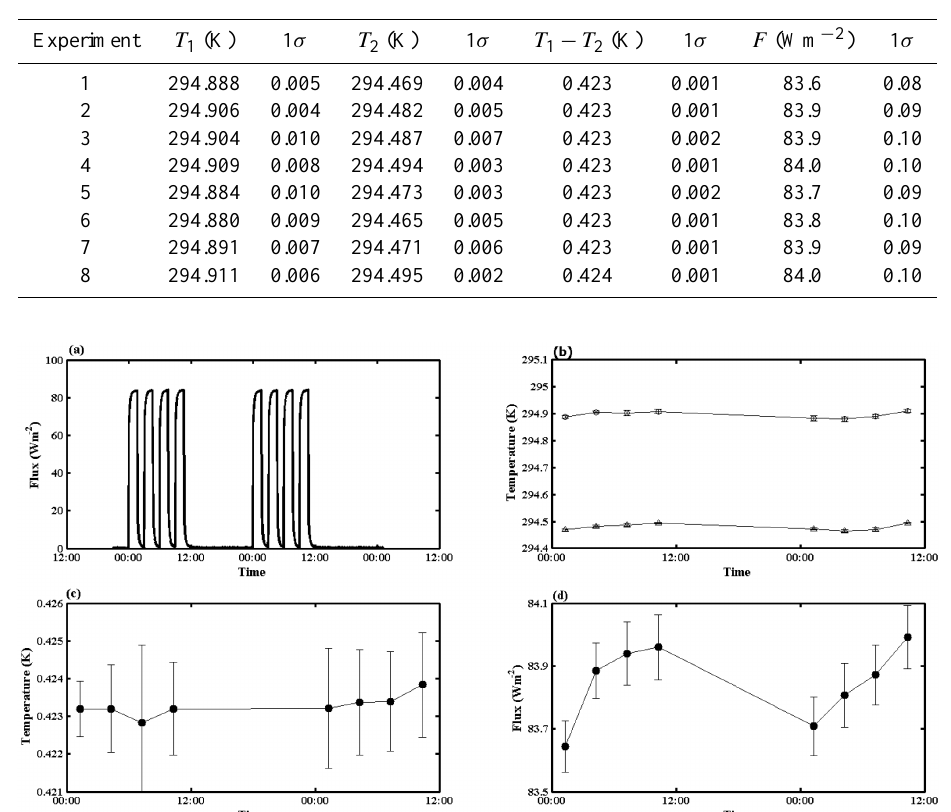
Table 1. Laboratory experiment results.